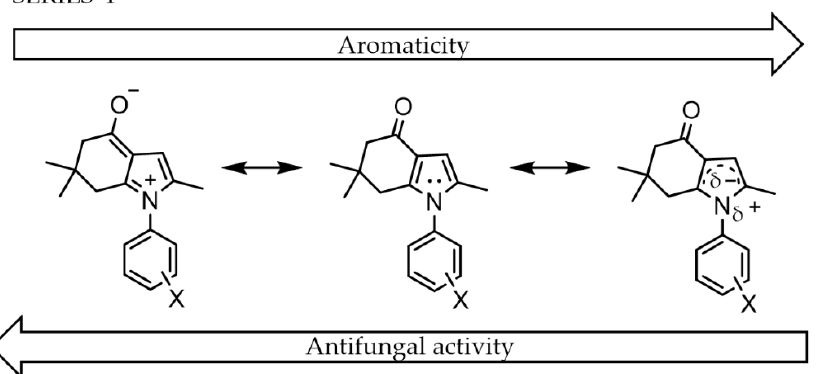
Scheme 1. Trend for the antifungal activity of indol-4-ones for series I ( 6 and 7a – g ) vs. NICS(0) NICS(1). Enolate and keto resonance structures.